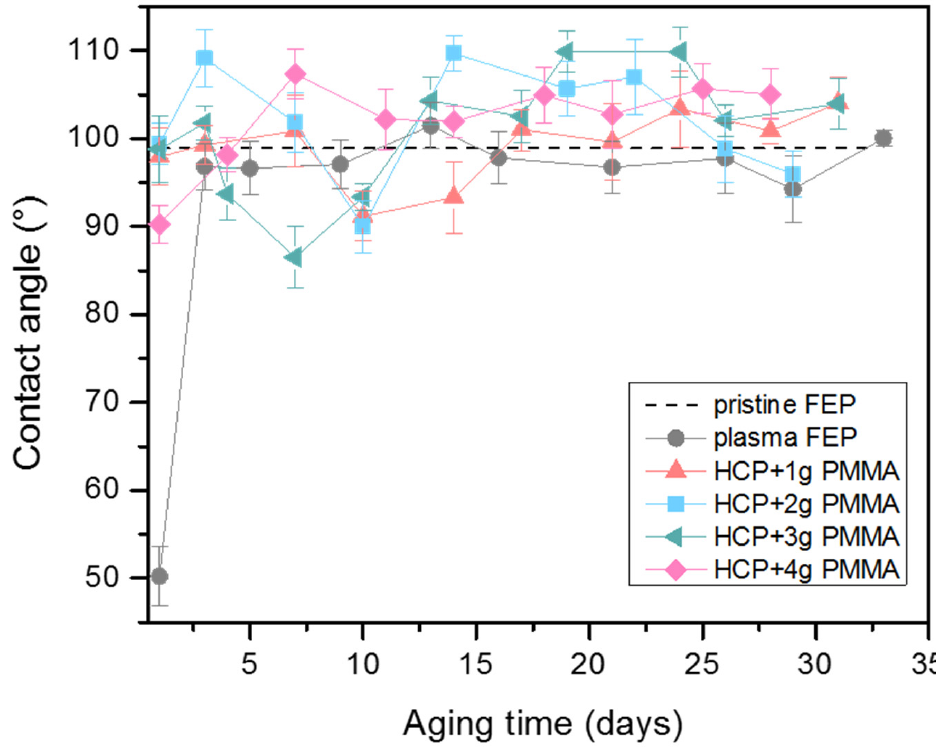
Figure 4. Water contact angles measurements over 34 days for pristine fluorinated ethylene propylene (FEP), plasma-treated FEP (plasma FEP), and honeycomb-like pattern (HCP) structure with incorporated polymethyl methacrylate (PMMA) of various content (1–4 g).